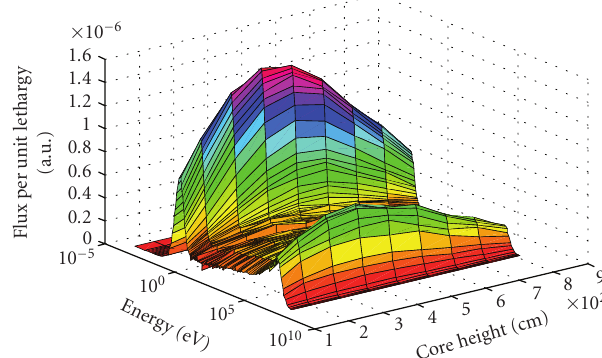
Figure 4: 3D space-energy neutron distribution in the reference LEU-fueled VHTR (neutron fluxes in compacts of the innermost fuel ring as a function of their axial locations in the VHTR core).